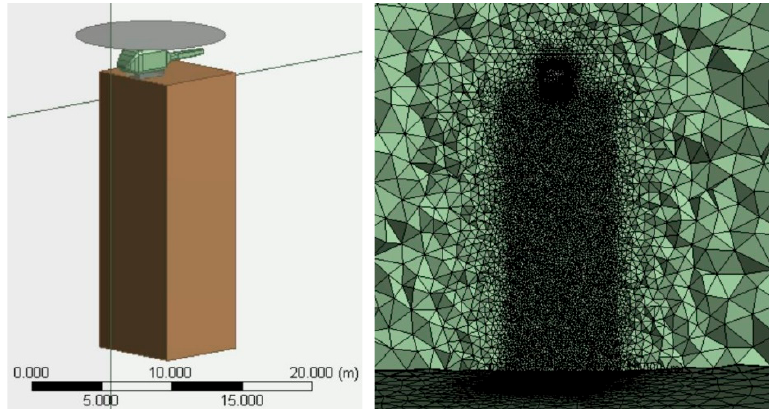
Figure 6. Fine mesh space region and mesh distribution.